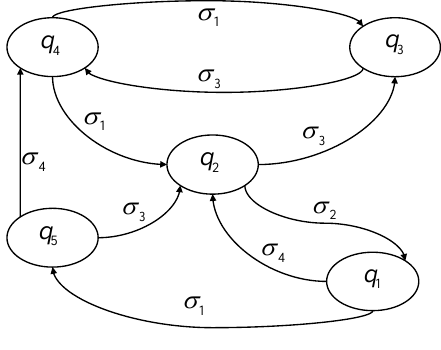
Figure 1. A simple example of the finite state machine